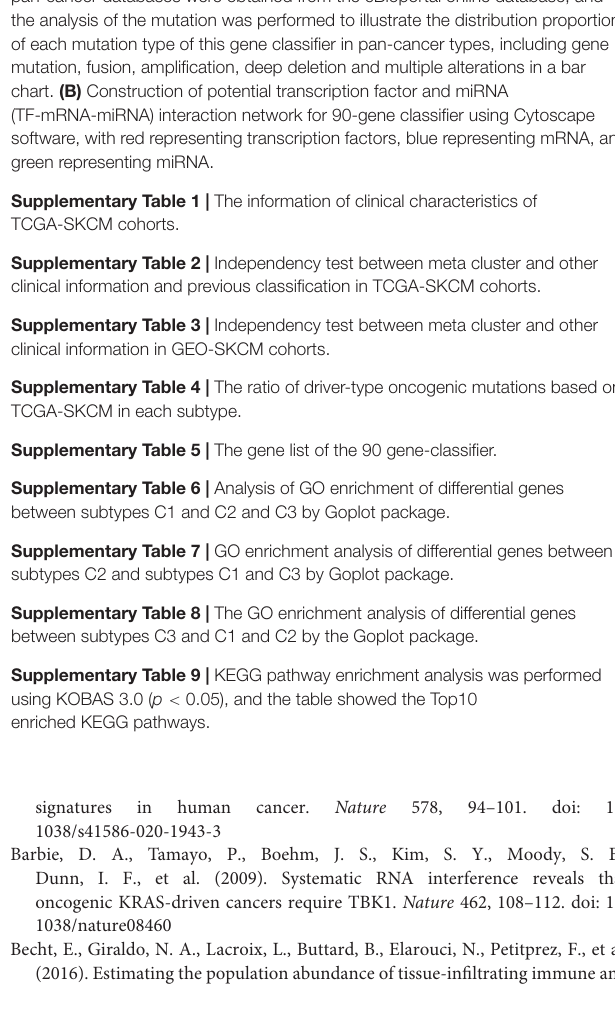
Supplementary Figure 1 | GO enrichment analysis of differential genes by Goplot package. GO enrichment of differential genes between C1 clusters and C2 and C3 clusters by the Goplot package, which is visualized as a taxonomic bubble plot (A) and a circle plot (B) . Venn diagram (C) of differential gene enrichment in “autophagy,” “protein binding,” “lysosome organization” three biological processes. Goplot package for GO enrichment of differential genes between C2 clusters and C1 and C3 clusters, and visualized as categorical bubble plots (D) and circle plots (E) . Venn diagram (F) of differential gene enrichment in the three biological processes “immune response,” “regulation of immune response,” “adaptive immune response.” GO enrichment of differential genes between C3 clusters and C1 and C2 clusters was carried out by the Goplot package and visualized in the form of classification bubble plots (G) and circle plots (H) . Venn diagram (I) of differential genes enriched in three biological processes: “protein binding,” “nucleotide-excision repair,” “DNA damage recognition,” and “poly(A) RNA binding.” Supplementary Figure 2 | KEGG pathway enrichment analysis was performed using KOBAS 3.0. The pathway figures depicted the common KEGG enrichment pathways for genes that are different between the three clustered subtypes and other subtypes. p < 0.05 pathways are considered significantly enriched.